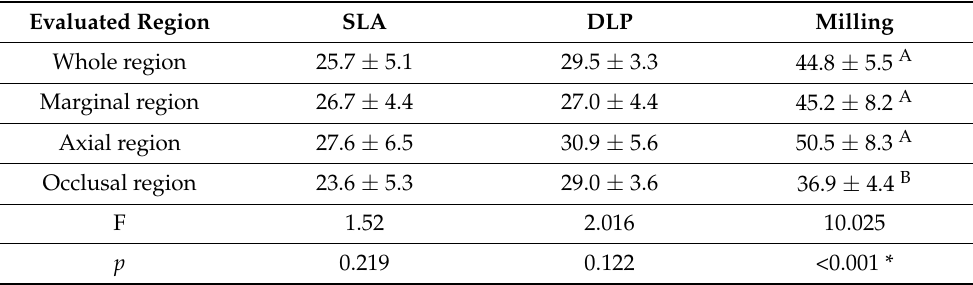
Table 2. Comparison of intaglio surface trueness (µm) of interim crowns according to the evaluated regions.